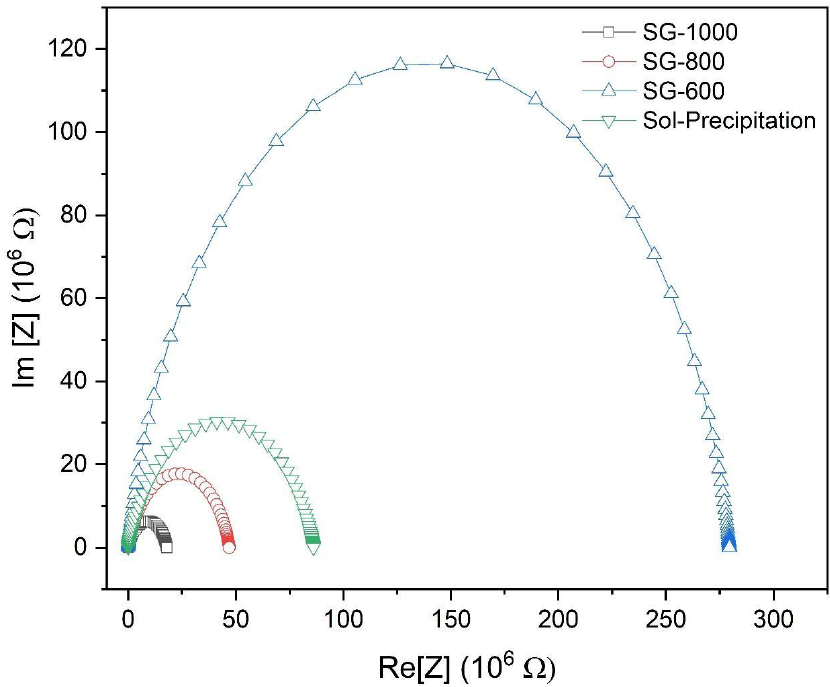
Figure 12. Complex impedance diagrams measured at room temperature, with an applied voltage of 1 V. The impedance spectrum is characterized by the appearance of semicircular arcs, whose pattern of evolution changes with increasing temperature. A variation in the per- fect semicircular shape is due to the loss of energy at the interfaces and other defects present in the network [15]. The presence of two semicircular arcs that indicate the elec- trical processes related to the grain (a small arc usually formed at frequencies below 100 kHz) was not observed in the impedance diagram; only a single arc referring to the elec- trical processes related to the grain boundary was observed. It is possible to observe that the resistance of the grain is very small when compared to the resistance of the grain boundary contour, which corresponds to the semicircle diameter. This result indicates that the calcination temperature was insufficient to generate a grain size for which the strength of the generated boundary was relevant [16]. Figure 13a shows the variation in the dielectric constant with the frequency for dif- ferent calcination temperatures. The dielectric constant has higher values for calcined powders at higher temperatures and at lower frequencies (below 100 kHz); in fact, the dielectric constant is so high that the equipment could not accurately measure its con- stant below 20 kHz. For higher frequencies, little variation was observed for the electrical capacity values.